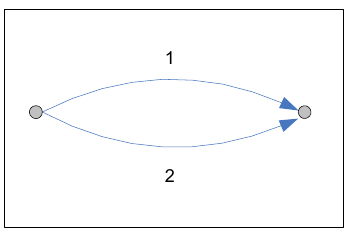
Figure 2. Two-link